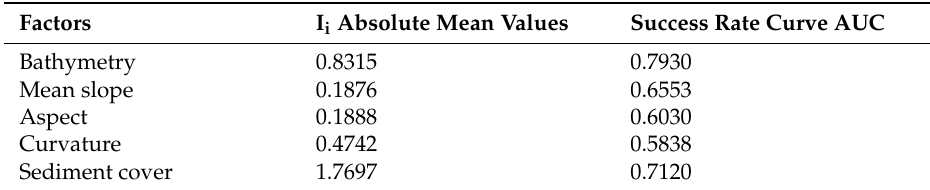
Table 3. Absolute mean values and area under the curve (AUC) values for each one of the predisposing factors, based on the information value (IV)